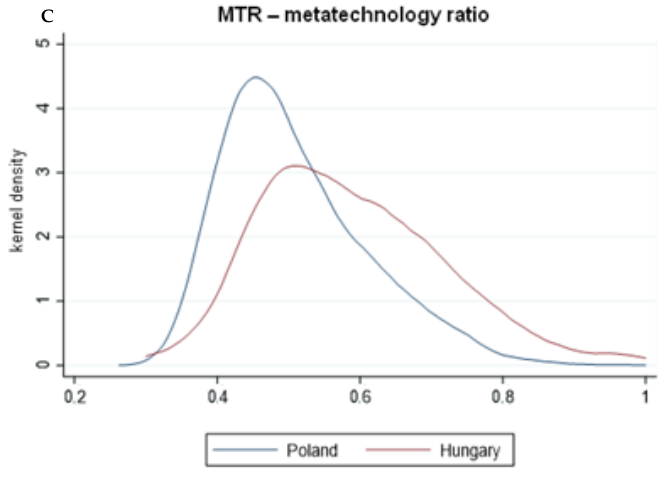
Figure 1. Kernel density plots for efficiency parameters. ( A ) TE k —technical efficiency to the country frontier; ( B ) TE—technical efficiency to the metafrontier; ( C ) MTR—metatechnology